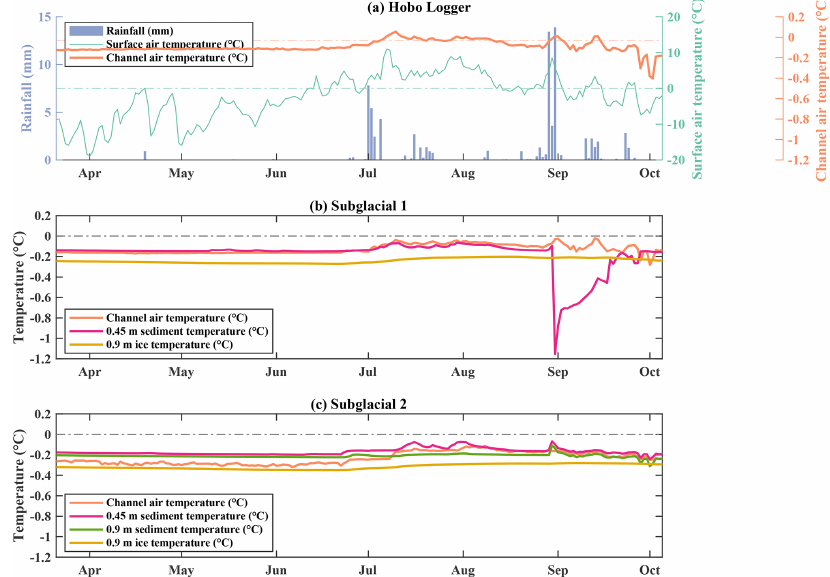
Figure 7. Observed subglacial daily mean temperatures at Tellbreen during 2019. Panel (a) Time series of subglacial channel air temperature at Hobo location compared to modeled surface air temperature and modeled rainfall. (b) Channel air, 0.45m depth sediment and 0.9m depth ice temperature at location Subglacial 1 next to the source of the running water. (c) Channel air, 0.45m depth sediment, 0.9m depth sediment and 0.9m depth ice temperature at location Subglacial 2 at the end of the drainage system.